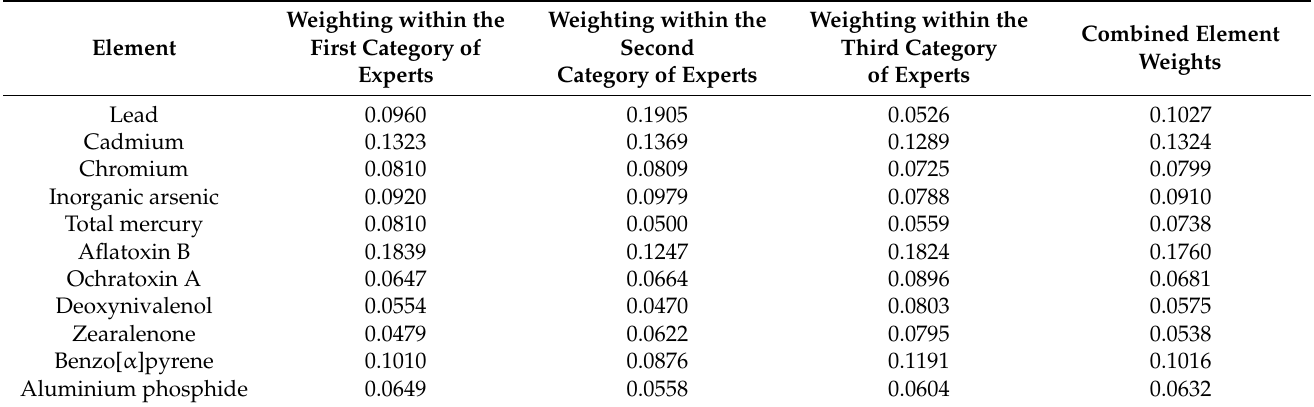
Table 4. Weights within expert categories and combined elements